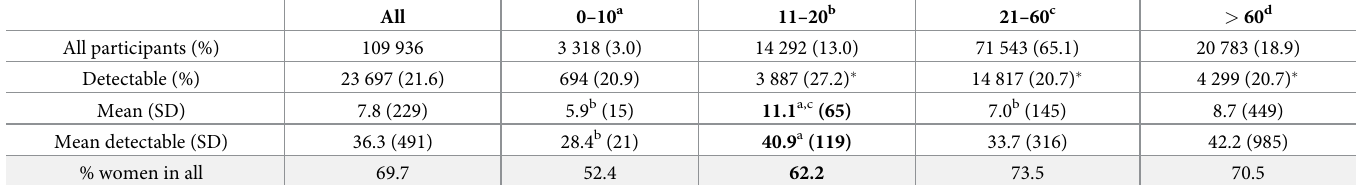
Table 5. Population, participants with detectable contamination, mean and standard deviation of 137 Cs concentration (Bq/kg), and women’s proportion in each age group.